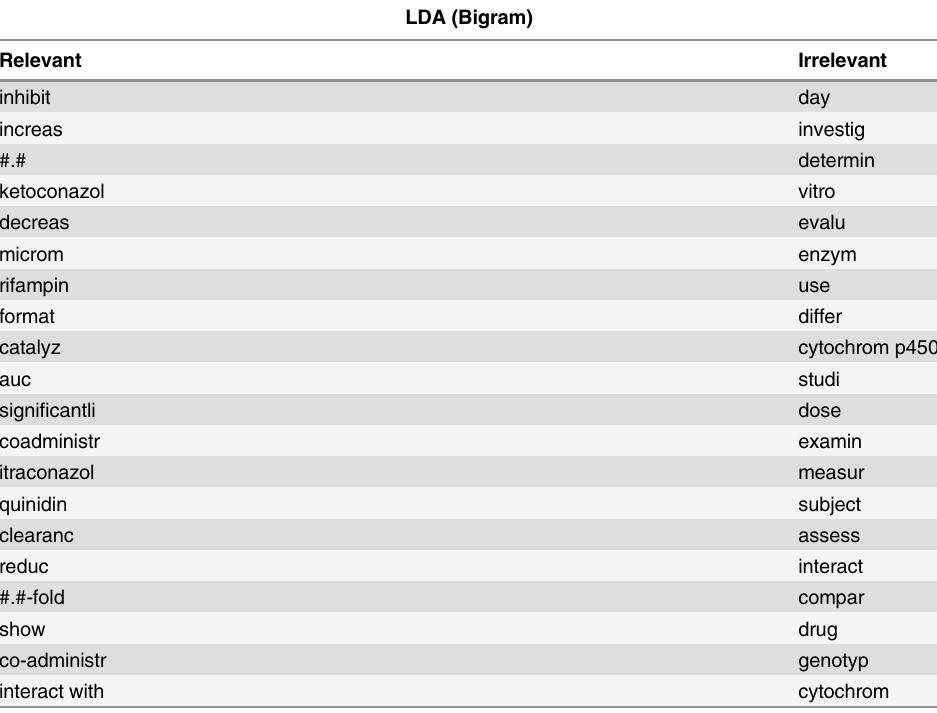
Table 5. Top 20 relevant and irrelevant sentence features. The most discriminative features of relevant and irrelevant classes in the sentence task, as chosen by the top-performing classifiers according to the RP3 measure: LDA on